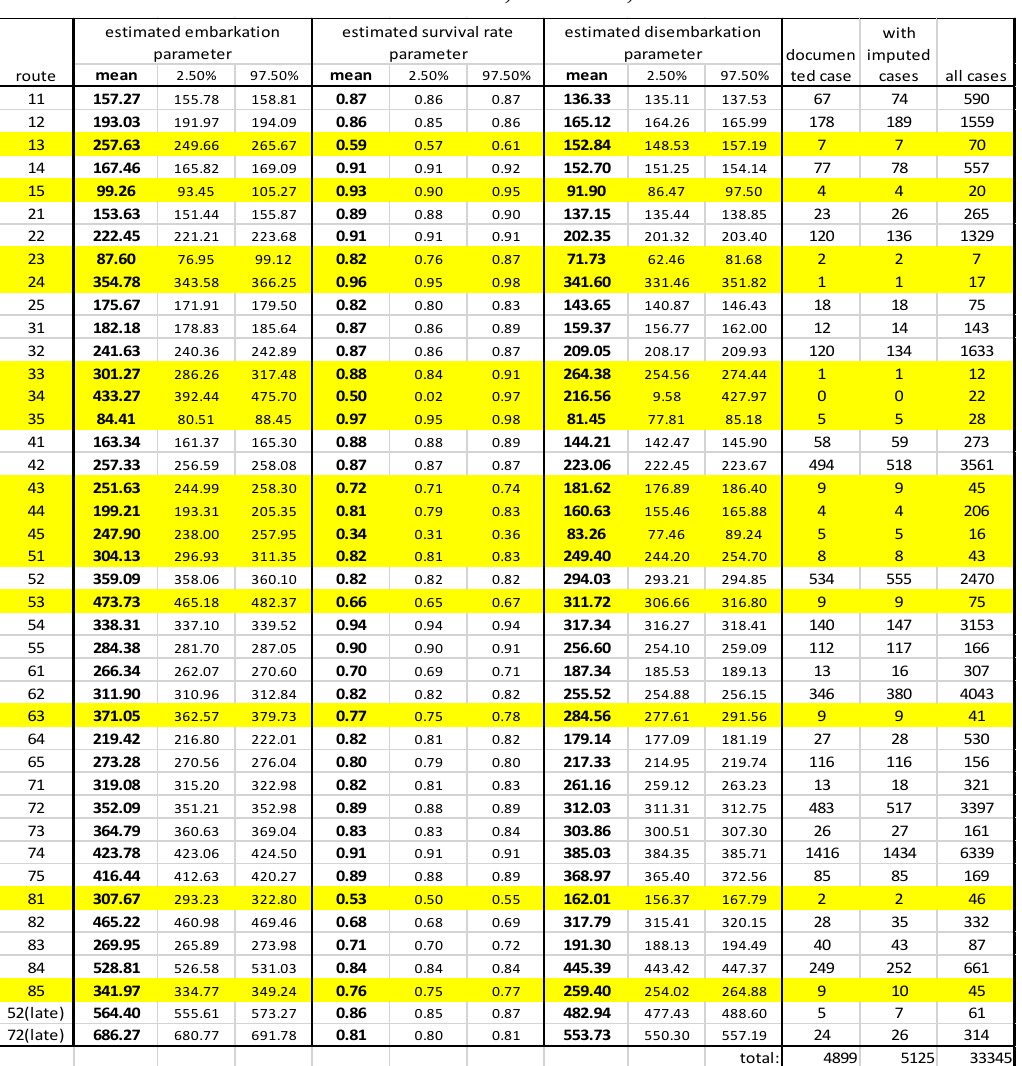
Table 3. Estimated captive flows for all known voyages: Parameters for Embarkations, Arrivals, and Loss Rates .